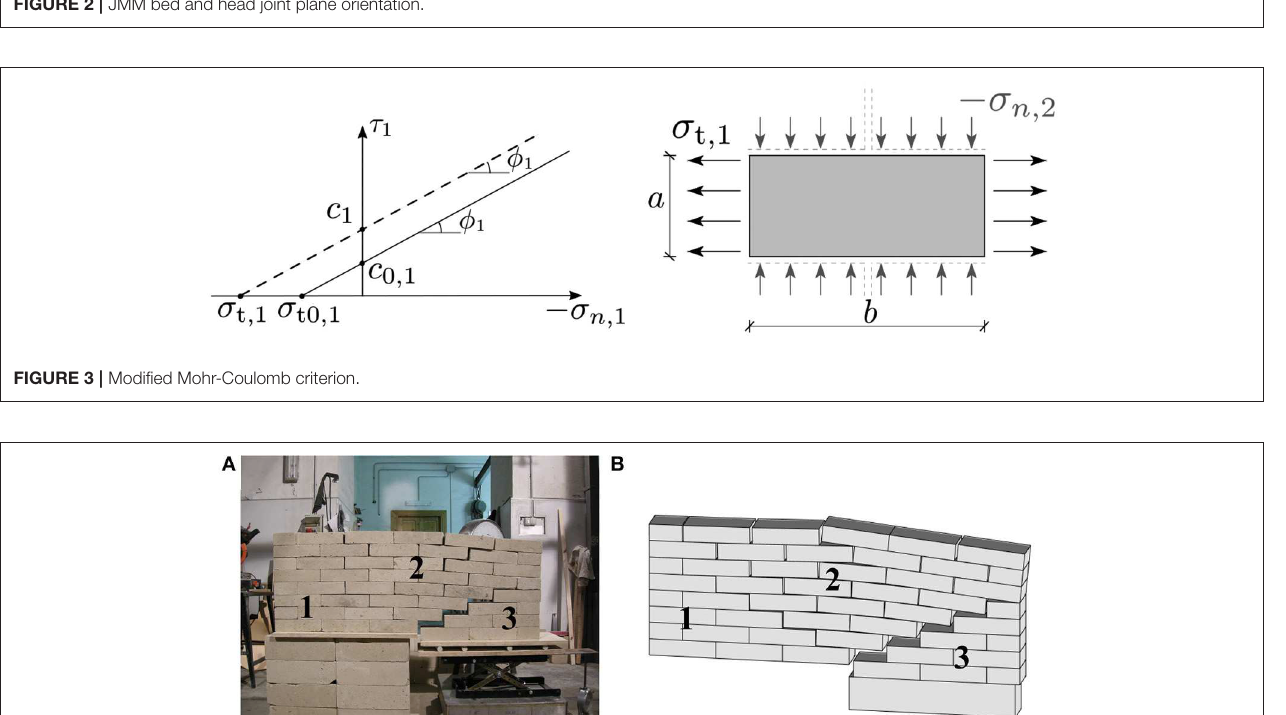
FIGURE 4 | (A) Experimental and (B) Numerical results for Test 8C. [Courtesy of Prof. F.